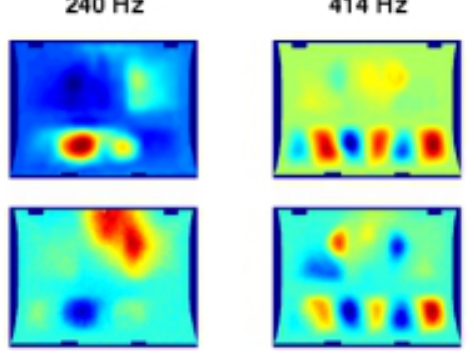
Fig. 7. Mode shapes (upper: MLE, lower: FRF